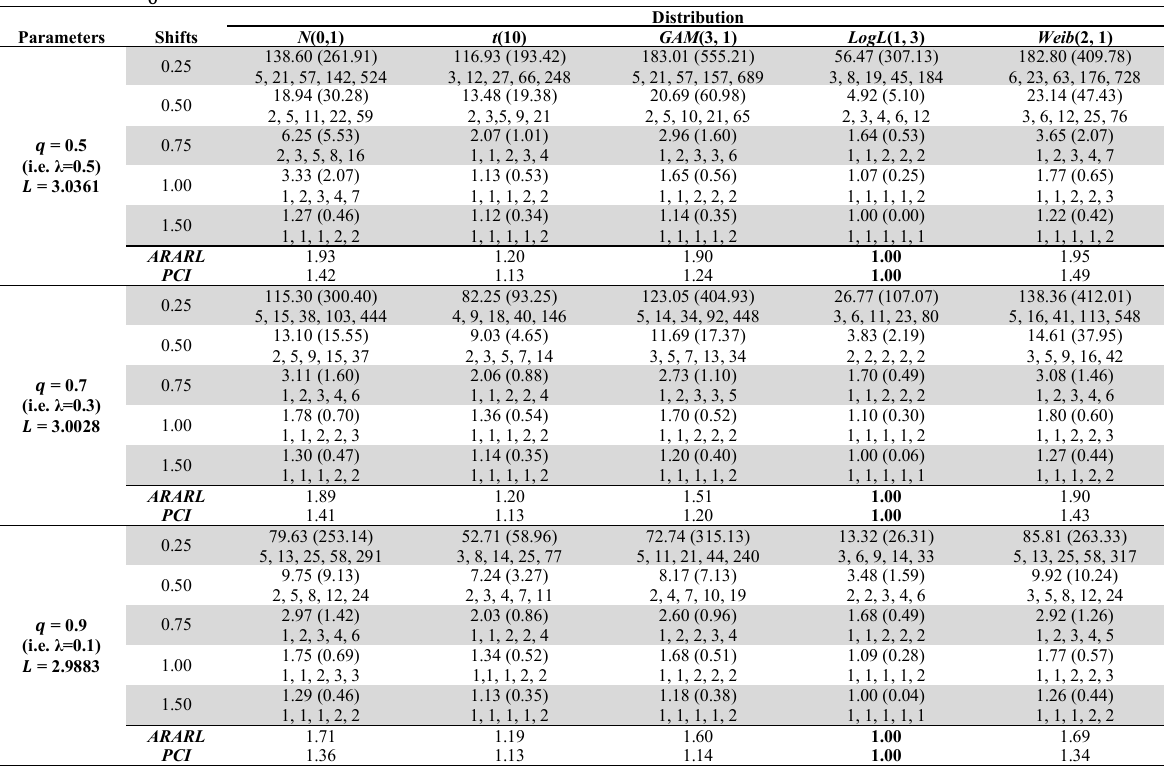
= 1.5 for (cid:3040)(cid:3028)(cid:3051)